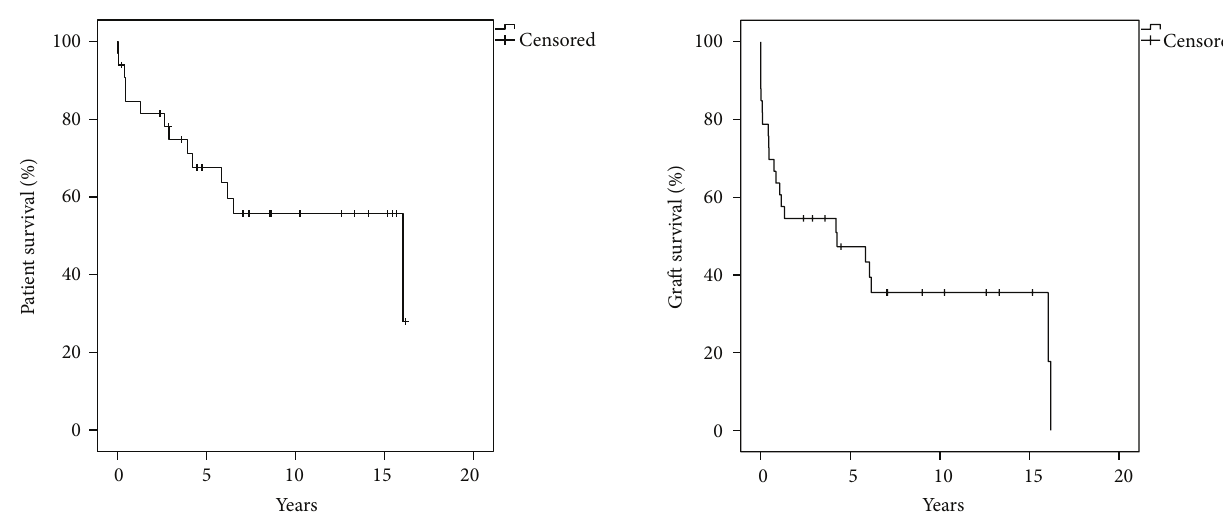
Figure 1: Patient survival after high-urgency renal transplantation. Figure 2: Graft survival after high-urgency renal